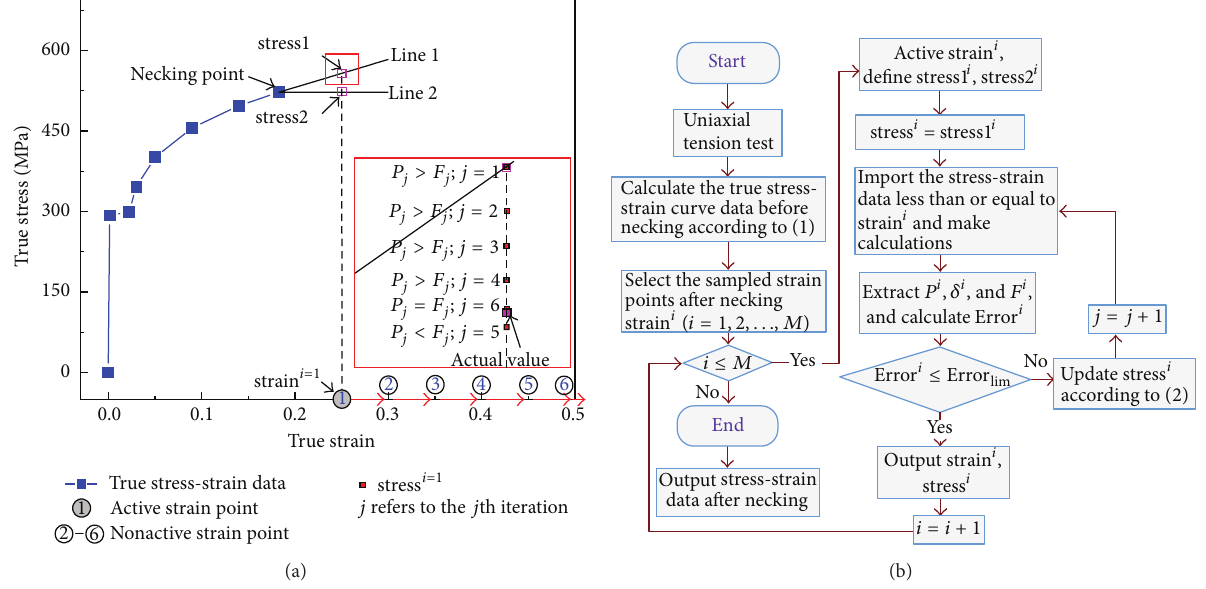
Figure 3: (a) The modification processes of the true stress at “active strain point” strain 𝑖=1 . (b) The flow chart of